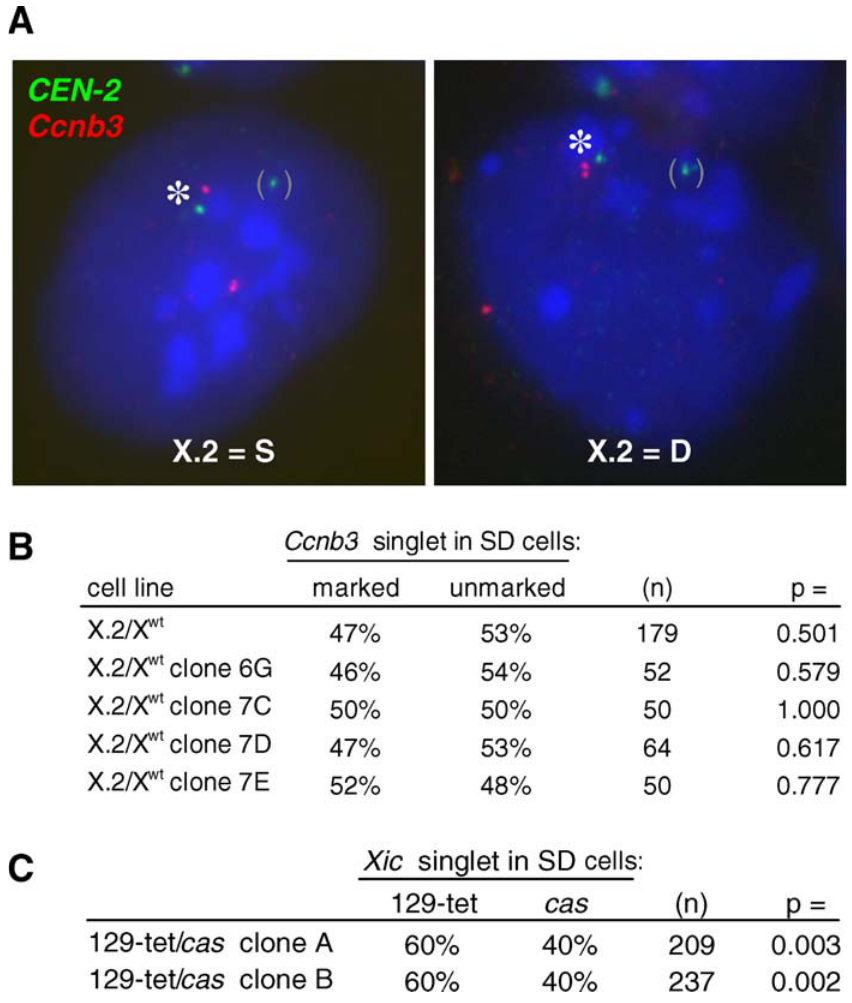
Figure 4. X Chromosomes Appear to Switch between States (A) The two SD signal configurations observed for Ccnb3 (red) by allele-specific FISH in X.2/X wt ES cells, in which one X chromosome is fused to Chromosome 2. The marked allele (asterisk) is scored by its proximity to a CEN-2 probe (green). The CEN-2 signal on wild-type Chromosome 2 is indicated by parentheses. (B) Allele-specific scoring of Ccnb3 in X.2/X wt ES and four single cell-derived clones. Nonsignificant p -values indicate a random distribution. (C) Scoring of allele-specific FISH for the Xic (Figure S2) in two independently derived 129-tet/ cas ES cell lines . p -Values indicate that the Xic on the 129 chromosome exhibits a singlet signal at a higher frequency than would be expected by random chance. DOI: 10.1371/journal.pbio.0040159.g004 PLoS Biology |